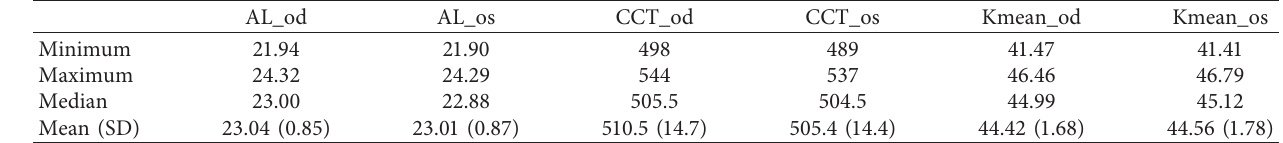
Table 1: Optical biometry data.